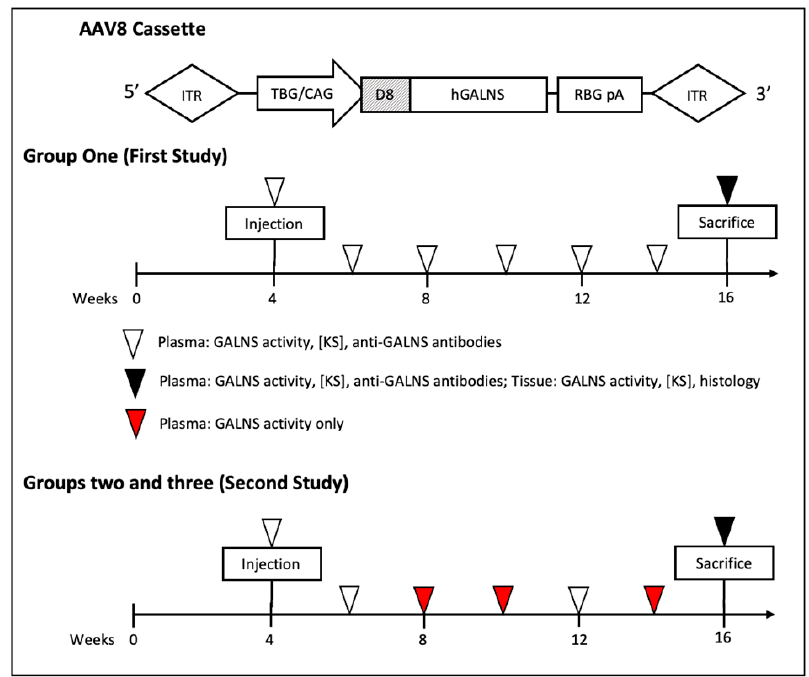
Figure 1. Cassette and study design. The experimental scheme of the first study was described by Sawamoto et al. [23]. AAV8: adeno-associated virus 8, ITR: inverted terminal repeat, TBG: